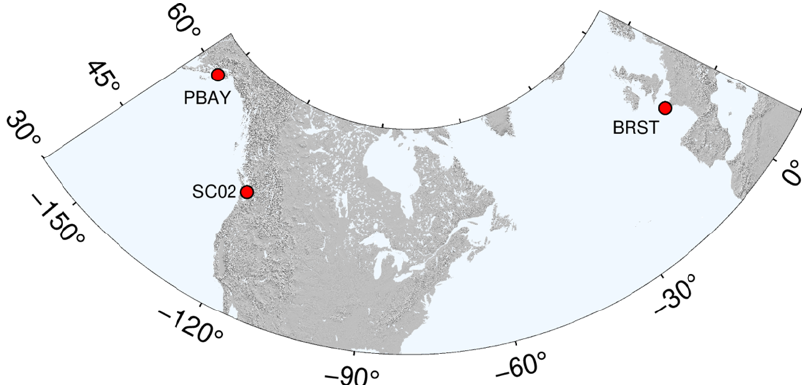
Figure A1. Geographic locations of the three GNSS sites we selected for this study.